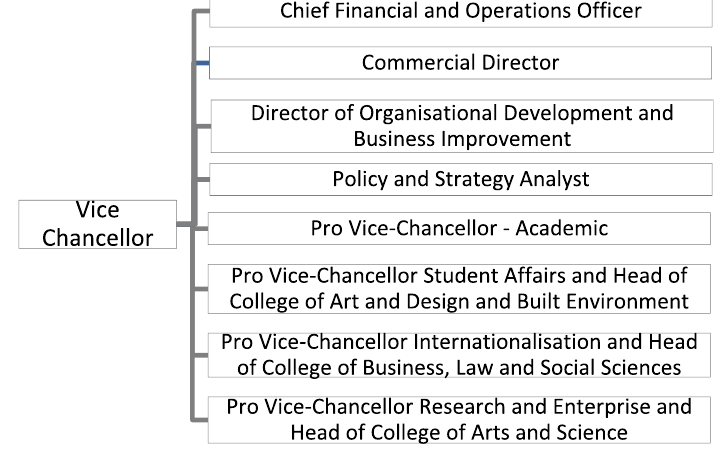
Figure 1. Senior management team at